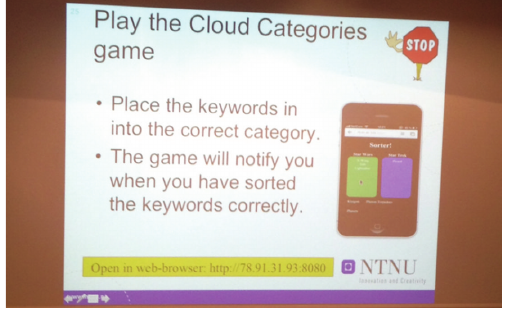
Figure 11: The introduction of the Cloud Categories